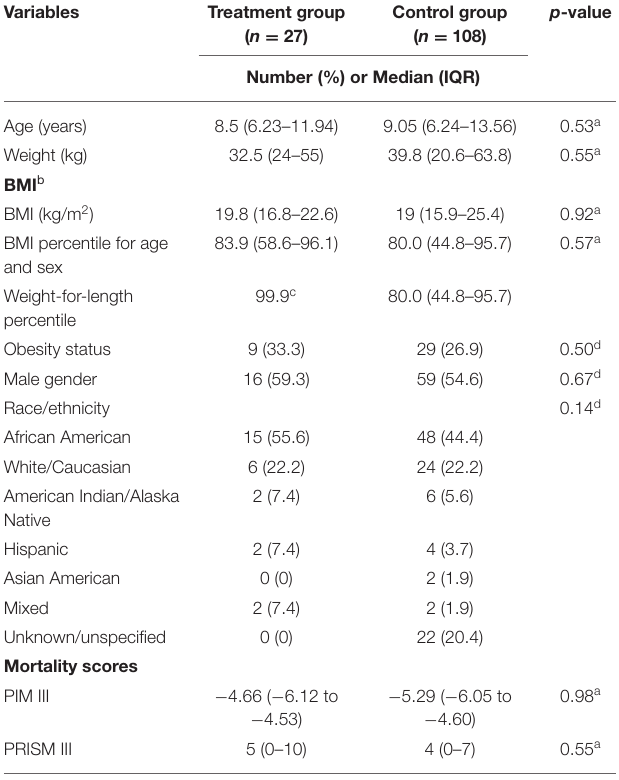
TABLE 1 | Patient demographics at PICU admission comparing treatment and control groups ( n =